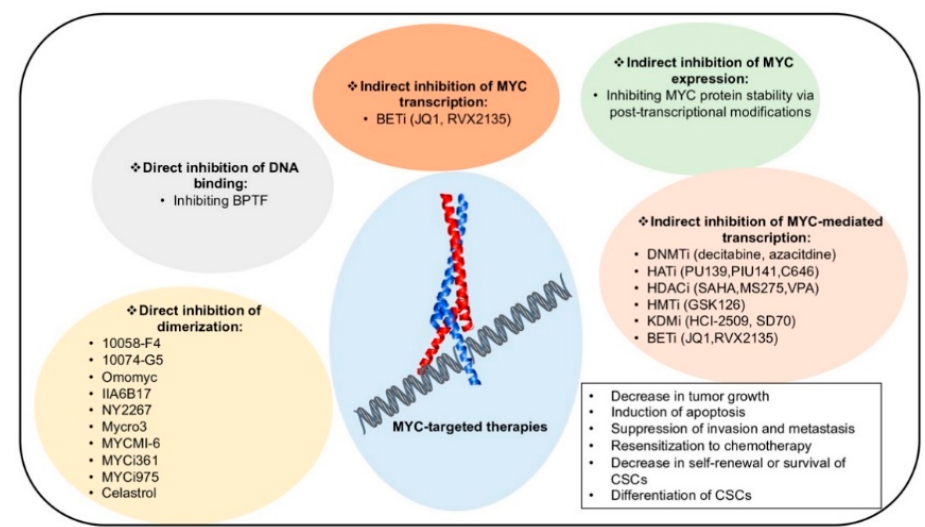
Figure 4. MYC-targeted therapies. Current therapies targeting MYC using direct and indirect inhibition strategies leading to tumor suppression.